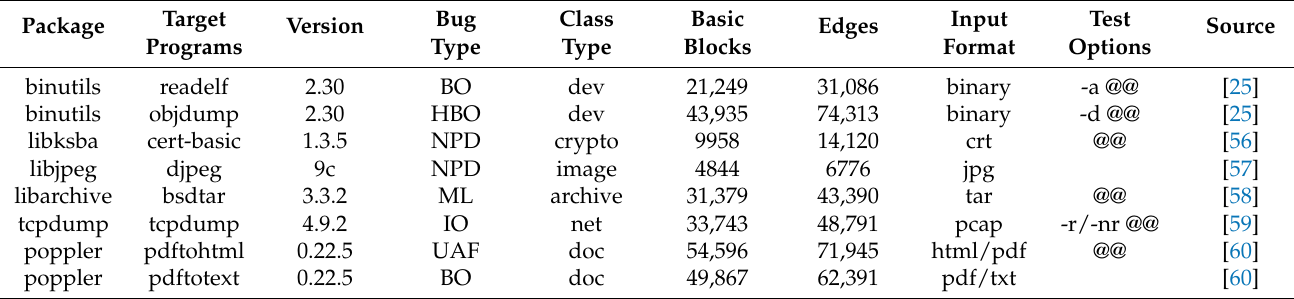
Table 6. Details of eight real-world